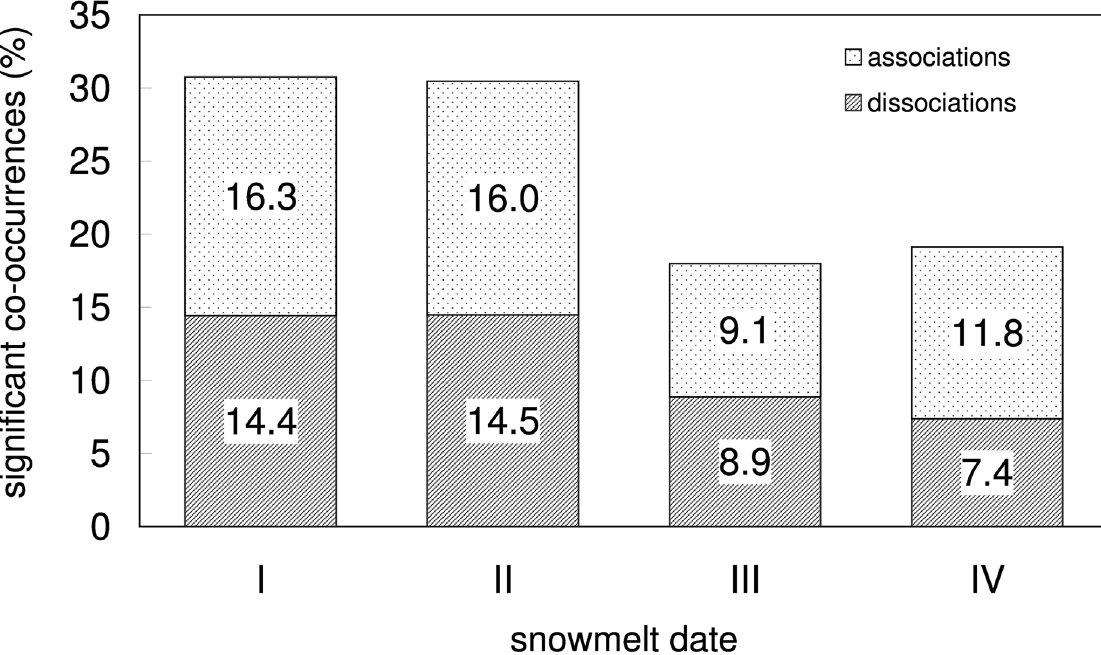
Fig. 2. Percentage of associations and dissociations out of all possible pair-wise co-occurrences for each snowmelt date. n for snowmelt dates I (2 Jun 2003) = 31 species, II (9 Jun 2003) = 26 species, III (16 Jun 2003) = 29 species, IV (23 Jun 2003) = 17 species. All spe- cies with an occurrence of less than 5% were excluded from pair-wise analyses.